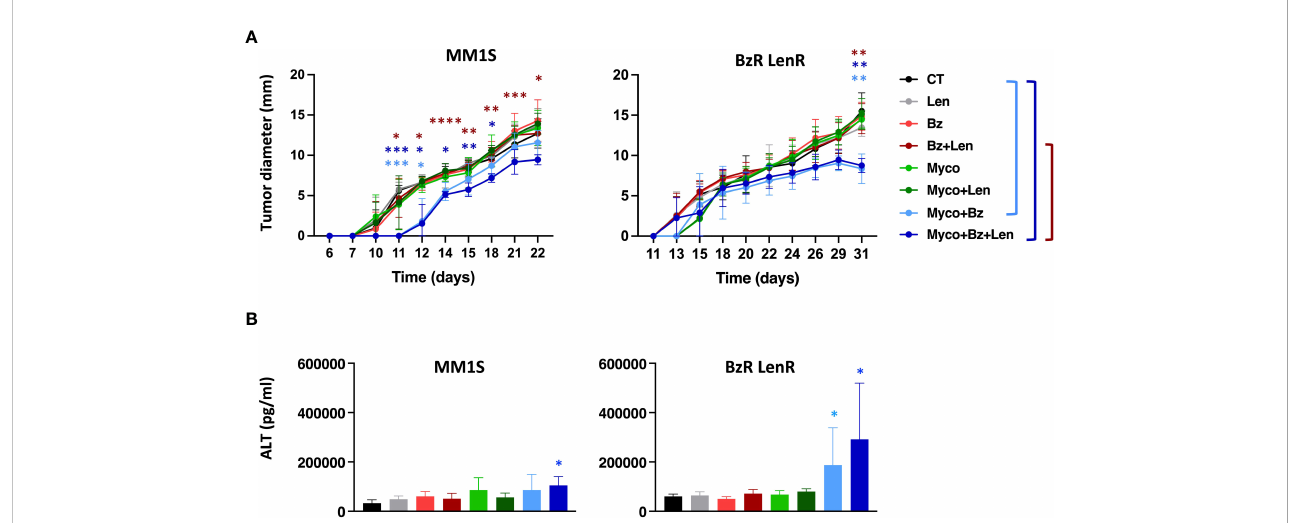
FIGURE 3 In vivo evaluation of Sec61 blockade in treatment of drug-sensitive and -resistant MM. (A) NSG mice (N = 6) were injected subcutaneously with 3.10 6 MM1S (parental) or its BzR LenR daughter at day 0. Seven days later, mice were treated with DMSO, Bz (0.5 mg.Kg -1 ), Myco (0.3 mg.Kg -1 ) and/or Len (50 mg.Kg -1 ) every 3.5 days. Myco and Bz were administrated by the intra-peritoneal route and Len by oral gavage. Tumor growth was followed by daily measurement of the tumor diameter. Data are Mean tumor diameters ± SD and represent cumulative data from 2 independent experiments with 3 mice/ group. Difference between groups were analyzed with Tukey ’ s multiple comparison test using Two-way Anova, with mixed effect model for each time points: *p<0.05; **p<0.01; ***p<0.001. Only signi fi cant differences are shown. (B) Sera of the mice used in (A) were sampled at the end of the experiment and ALT levels assessed by ELISA. Differences between treated groups and control by one-way Anova followed by Tukey ’ s multiple comparison test (*p < 0.05; **p < 0.01; ***p < 0.001, ****p <